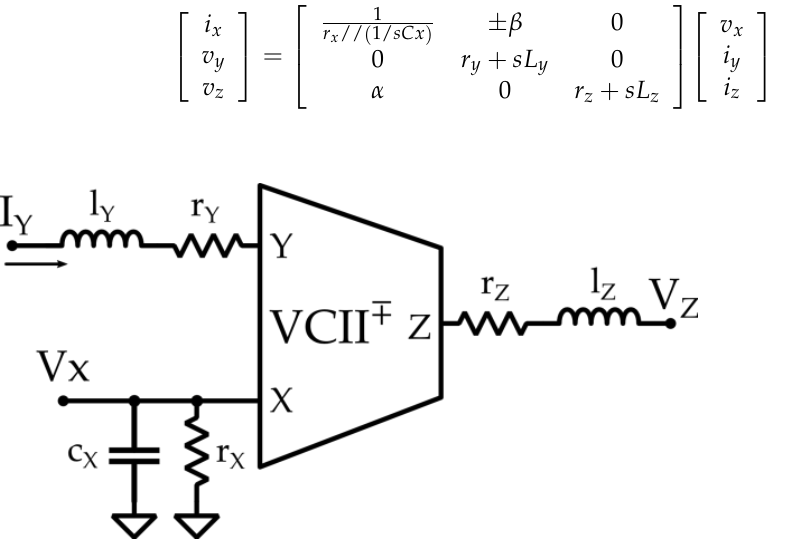
Figure 4. VCII high-level model including node parasitic impedances.